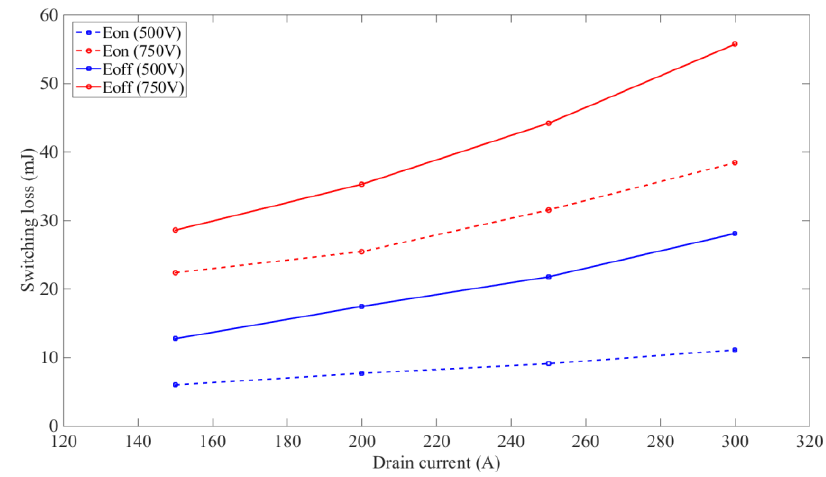
Figure 12. Eon and E o ff measured with 𝑅 𝑔 = 15 Ω and 𝑇 𝑗 = 125 ℃ at different device currents, I d and different voltages, V ds .